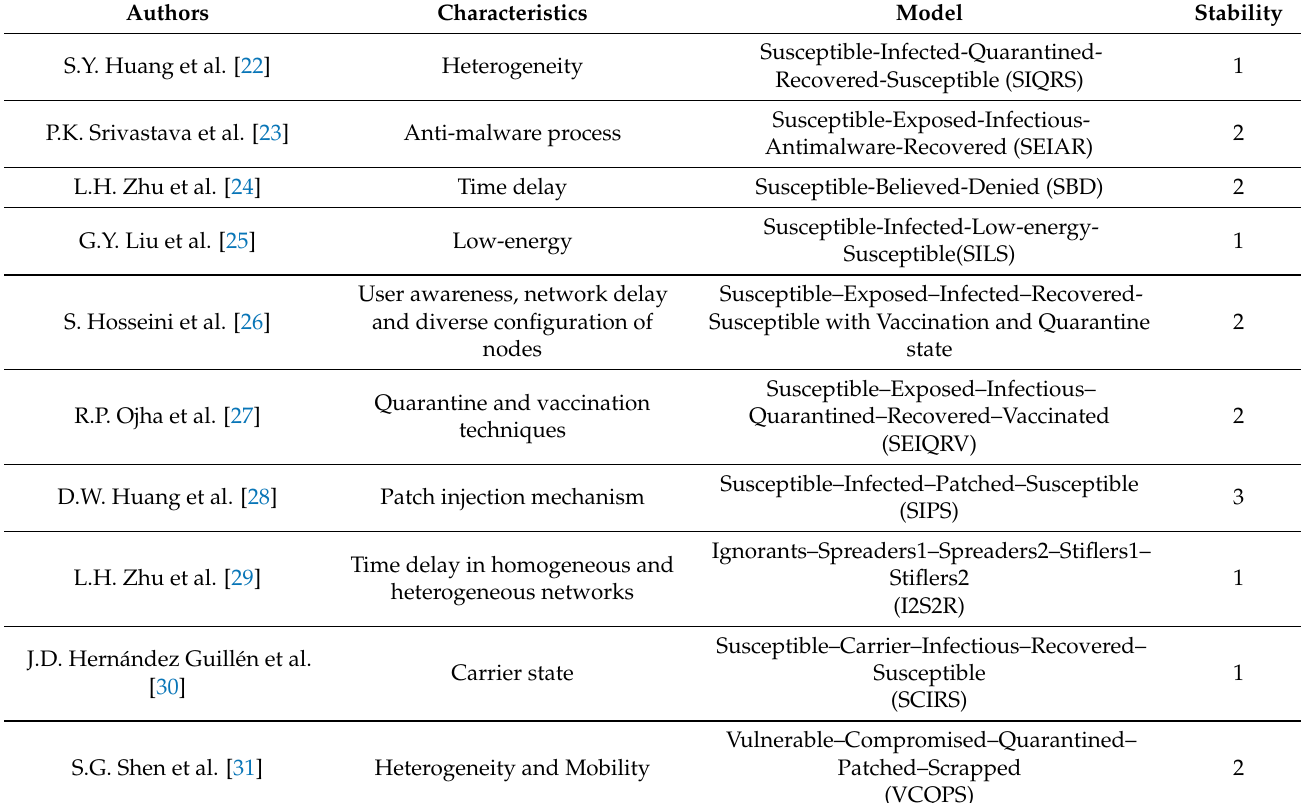
Table 2. Research on stability of epidemic model in